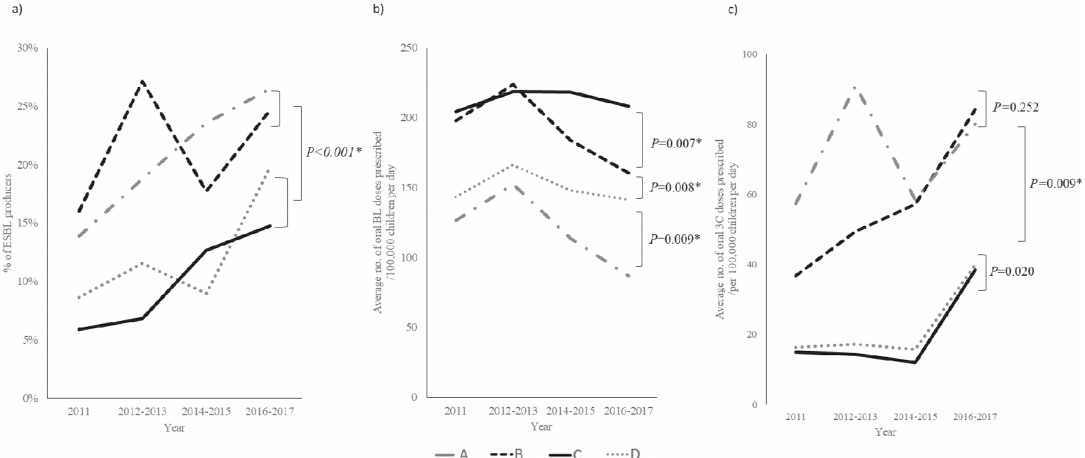
Figure 3. Trends showing ( a ) the proportions of UTIs caused by ESBL-producing uropathogens in hospitals A, B, C, and D. Hospitals A and B had significantly higher proportions of ESBL producers compared to hospitals C and D. ( b ) The average number of oral BL doses prescribed in regions A, B, C, and D. Regions C and B had higher oral BLs prescribed per 100,000 children per day compared to regions D and A. ( c ) The average number of oral 3C doses prescribed in regions A, B, C, and D. Regions A and B had higher oral 3Cs prescribed per 100,000 children per day compared to regions C and D. P < 0.05 are shown with an asterisk. BL, β -lactam; ESBL, extended-spectrum β -lactamase; 3C, third-generation